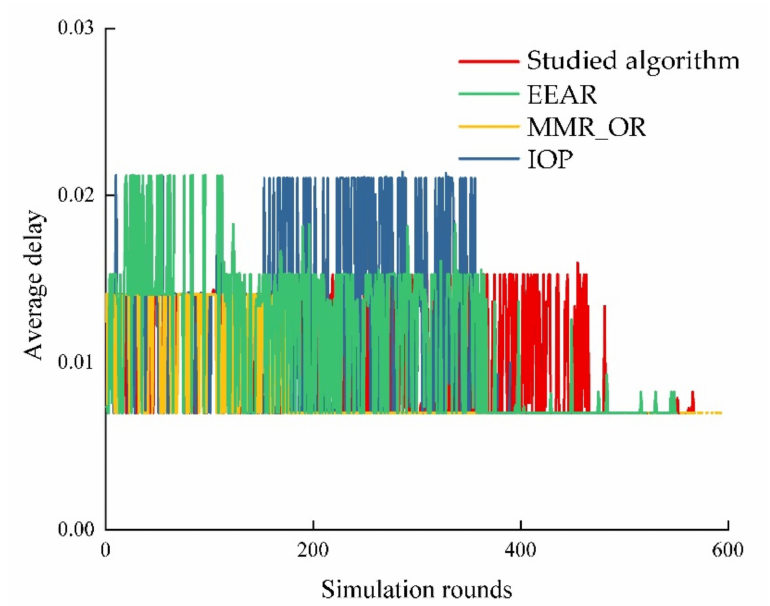
Figure 5. Comparison of the average delay.